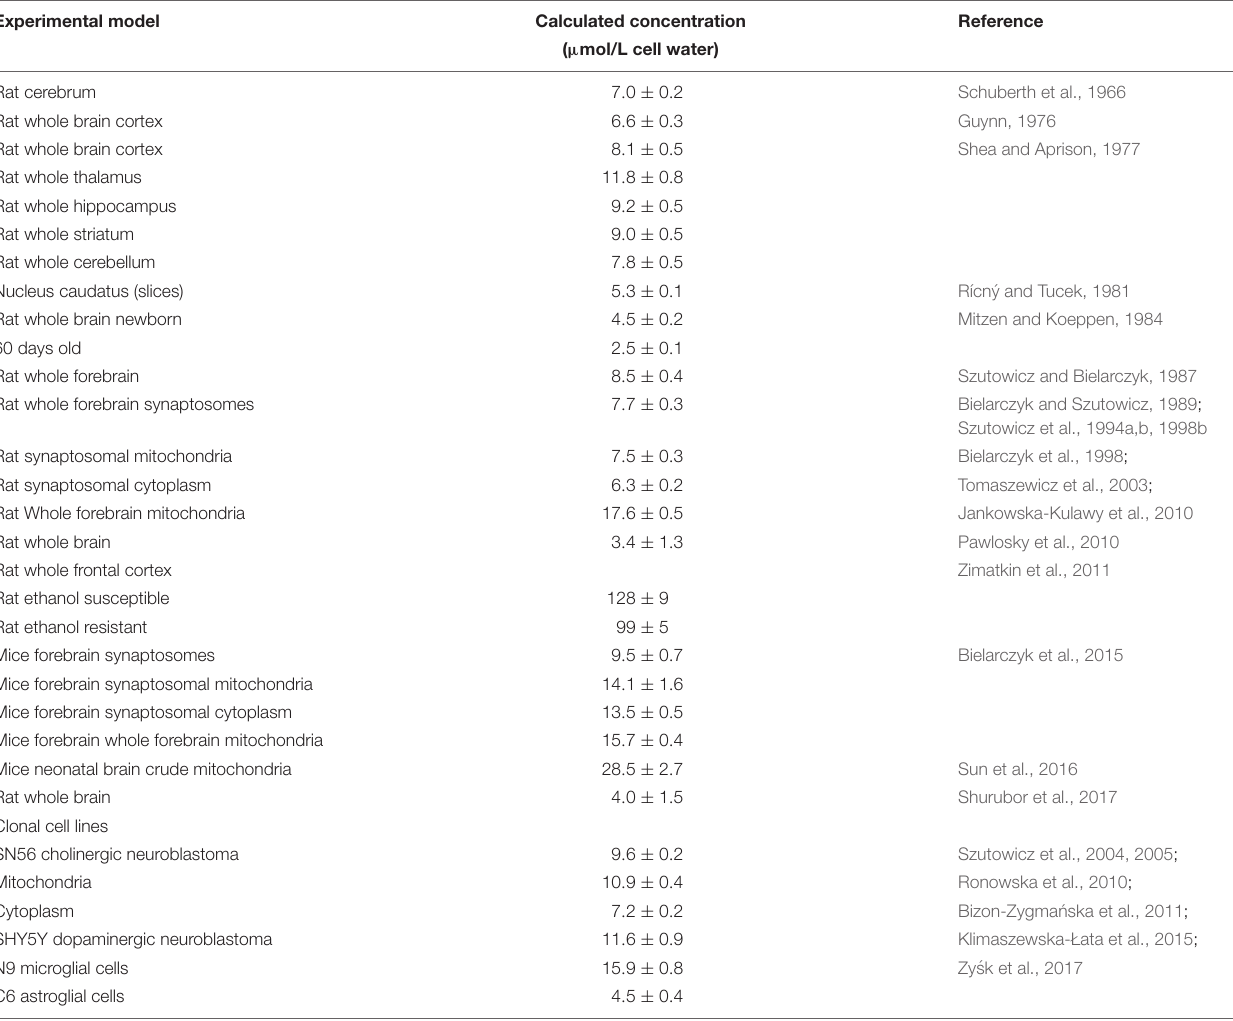
TABLE 2 | Estimated molar concentrations of acetyl-CoA in different compartments of the brain and clonal cells of brain origin. Experimental